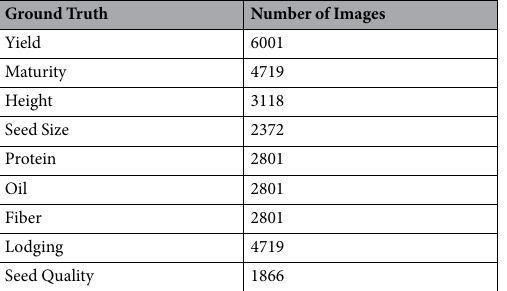
Table 3. The number of images having the corresponding ground truth